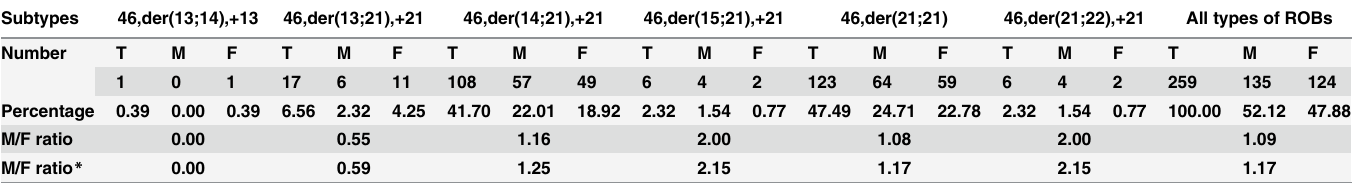
Table 2. Unbalanced Robertsonian translocations (ROBs) detected in Children.